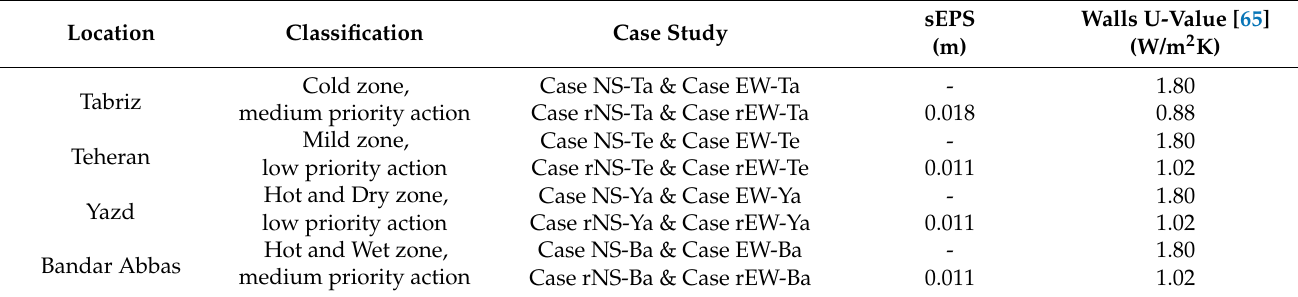
Table 5. Parameters of the case studies for the four Iranian